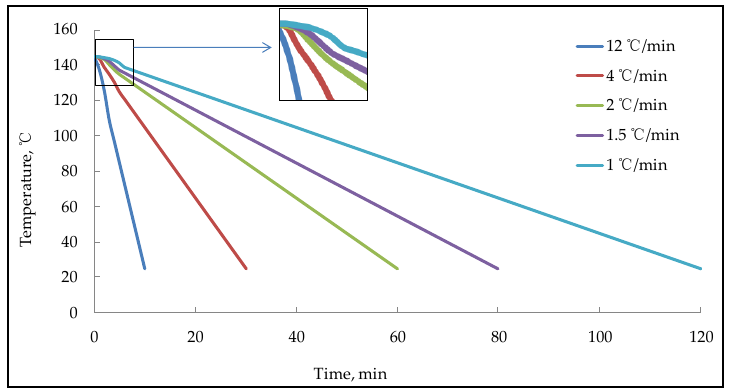
Figure 2. The measured cooling rate of the high and low temperature test chamber.